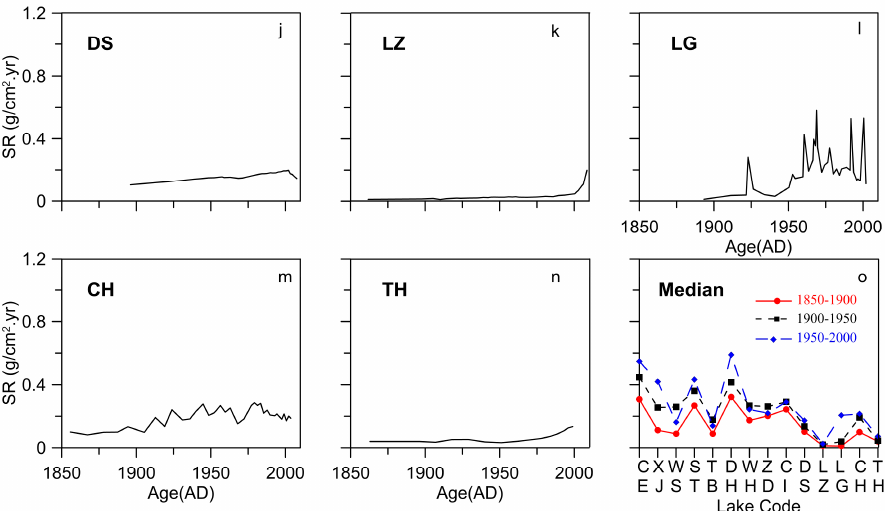
Figure 2. Sediment accumulation rates since 1850s in CE, XJ, WS, ST, TB, DH, WH, ZD, CI, DS, LZ, LG, CH and TH lake ( a – n ), respectively, and their median values in different time periods ( o ). Lakes are presented in order of increasing surface area. For lakes with multiple cores, TB, LL4, CH1 and MS were chosen, respectively, as the representative core in Taibai, Longgan, Chaohu and Taihu Lake (Data in b , f , g modified from [26,47,48], respectively); Lake code refers to Table 1.